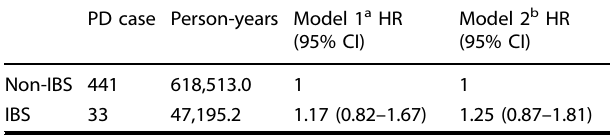
Table 4. Self-reported irritable bowel syndrome and Parkinson ’ s disease (PD) risk in SALT Swedish twins.